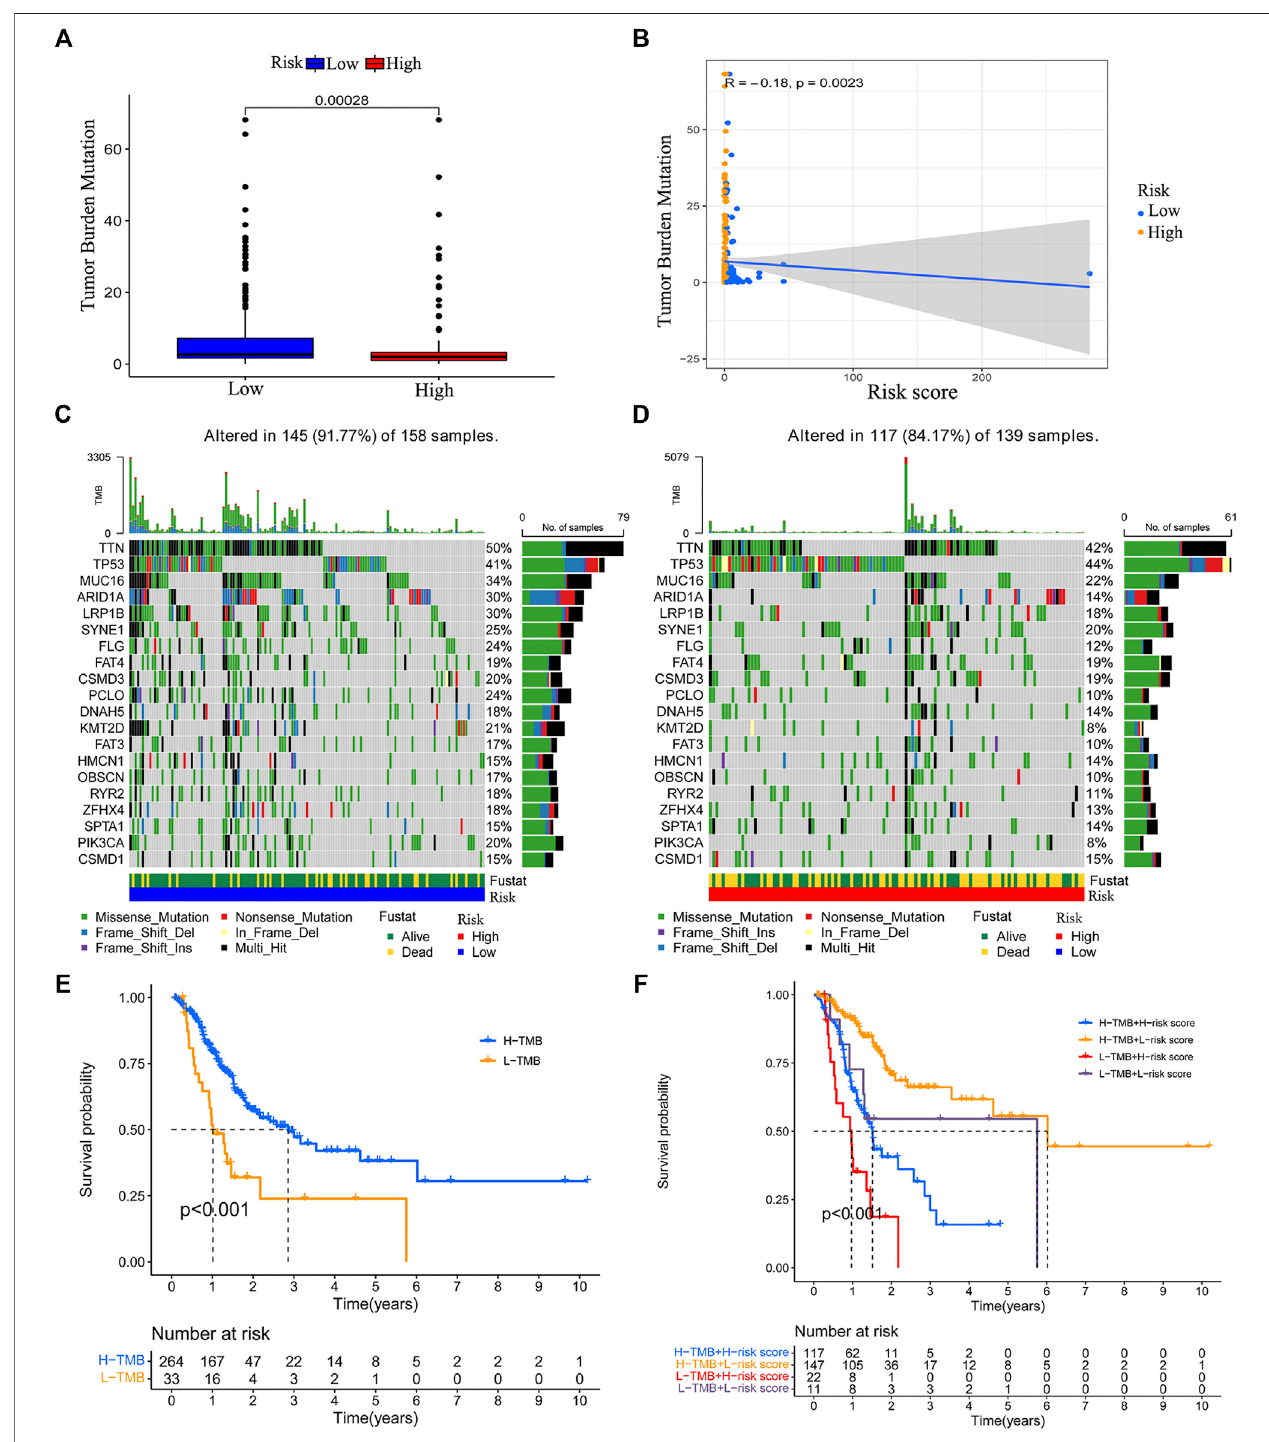
FIGURE 8 | Correlation between the risk model and tumor mutation burden (TMB). Boxplot was used to visualize the TMB level between the low-risk group and high-risk group (A) . The risk score is negatively correlated with the TMB level (B) . The top 20 genes ’ TMB in the low-risk group and high-risk group (C – D) . The survival differencebetweenthehighTMBgroupandlowTMBgroup (E) .Thesurvivalstatusofpatientswithloworhighrisk-scoreinthehighTMBgroupandlowTMBgroup (F) .